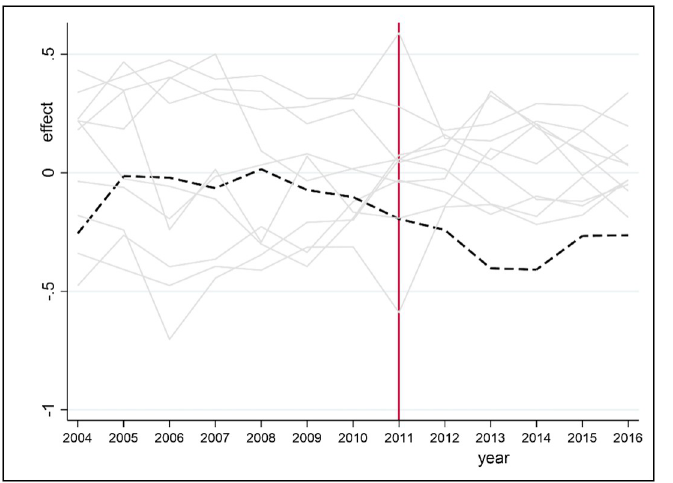
Fig 9. Prediction error distribution of NH 3 N for